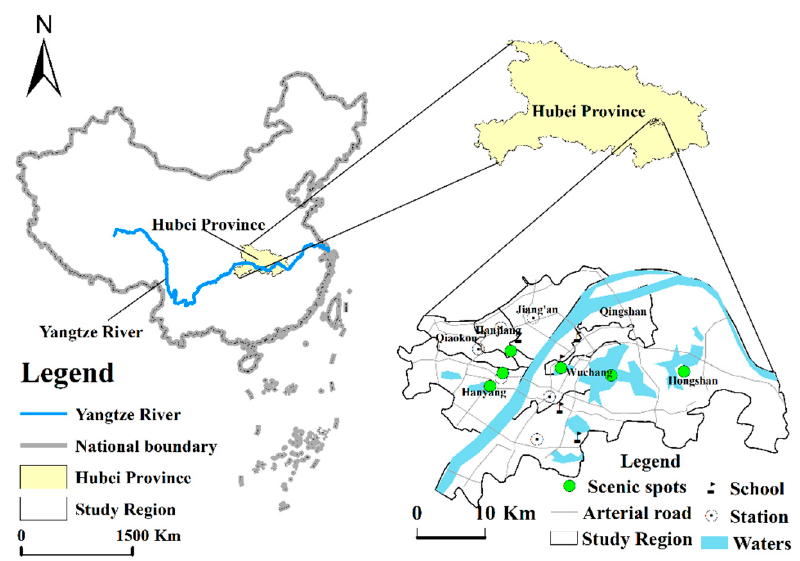
Figure 2. Map showing the location of Wuhan city center. Location map of the study area.